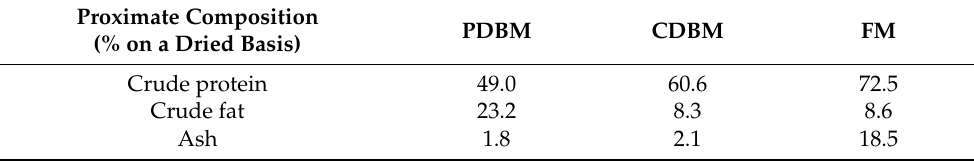
Table 3. Proximate composition of black soldier fly larvae meal in this study. Proximate Composition (% on a Dried Basis)